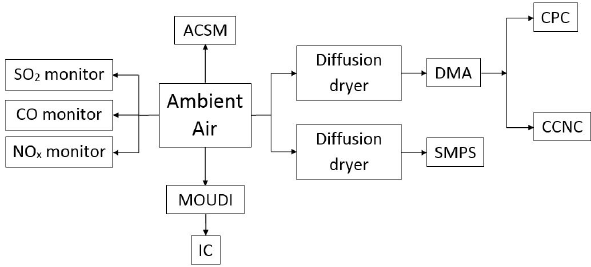
Figure 1. Schematic of the main components of the experimental set-up, which included SO 2 , CO, and NO x monitors, an aerosol chemical speciation monitor (ACSM), micro-orifice uniform de- posit impactor (MOUDI), ion chromatograph (IC), differential mo- bility analyser (DMA), condensation particle counter (CPC), cloud condensation nuclei counter (CCNC), and a scanning mobility par- ticle sizer (SMPS). The ACSM, and SO 2 , CO, and NO x monitors were in a neighbouring